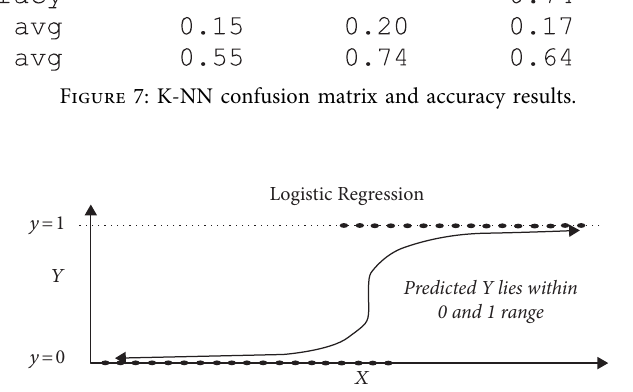
Figure 8: Logistic regression: